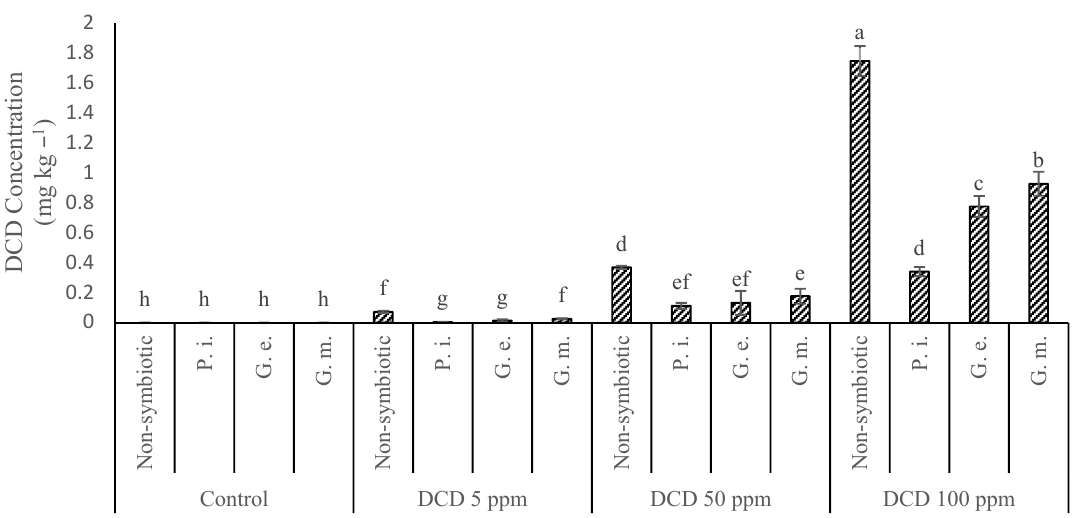
Figure 6. The main effect of dicyanodiamide in leaves of lettuce on carotenoid content. (The means refer to four repetitions ± SD. Different letters for each parameter indicate significant differences assessed ( p < 0.05).)